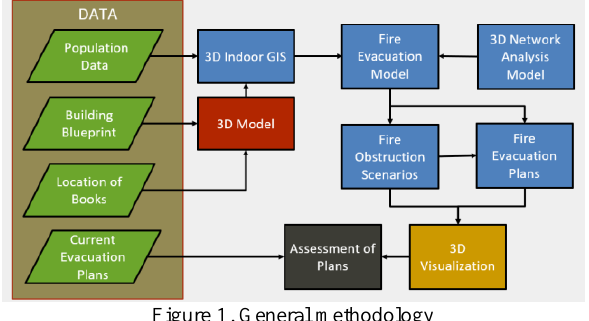
Figure 1. General methodology